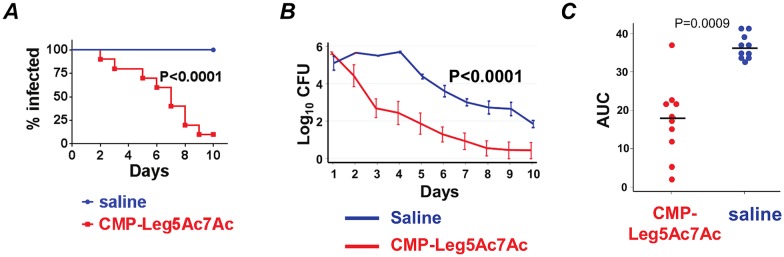
CMP-Leg5Ac7Ac treatment reduces the duration and burden of ceftriaxone-resistant (CRO-R) N. gonorrhoeae (Ng) H041 in the BALB/c mouse vaginal colonization model.Two groups of 17β-estradiol treated BALB/c mice (n = 10/group) were challenged with 9 x 105 CFU Ng H041. One group received CMP-Leg5Ac7Ac 10 μg/ml intravaginally daily; the other group received saline (vehicle control). Vaginal swabs were obtained daily to quantify Ng CFUs. A. Kaplan Meier analysis of time to clearance. B. Colonization of bacteria (log10 CFU) measured daily. C. Bacterial burdens consolidated over time (Area Under the Curve [log 10 CFU] analysis) for the two groups.